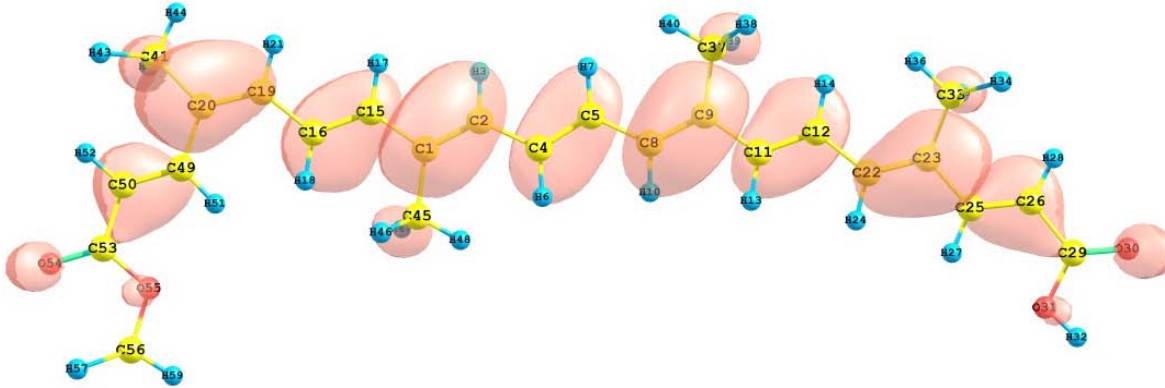
Figure 6. HOMO and LUMO of the bixin molecule calculated at the M05-2X/6-31+G(d,p) level of